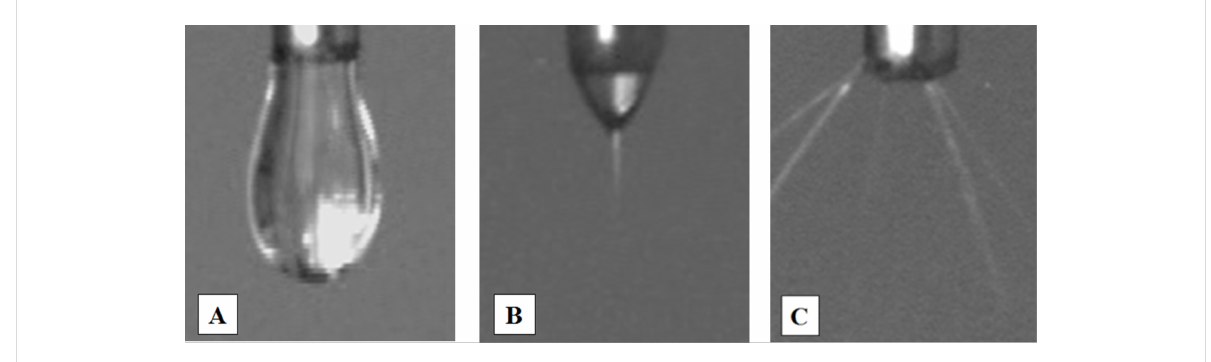
Figure 3: Geometric shape of the liquid meniscus at the outlet of the nozzle for 20% PVP solution with flow rate 1.2 mL/h and electrical voltage: (A) below the low level (4 kV); (B) within the experimental domain (7.5 kV); (C) greater than the high level (17 kV).